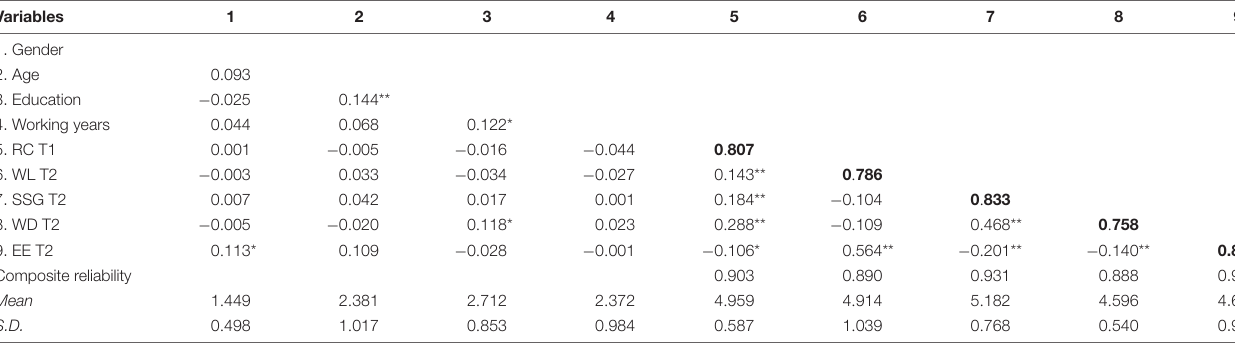
TABLE 2 | Means, standard deviations, and correlations.